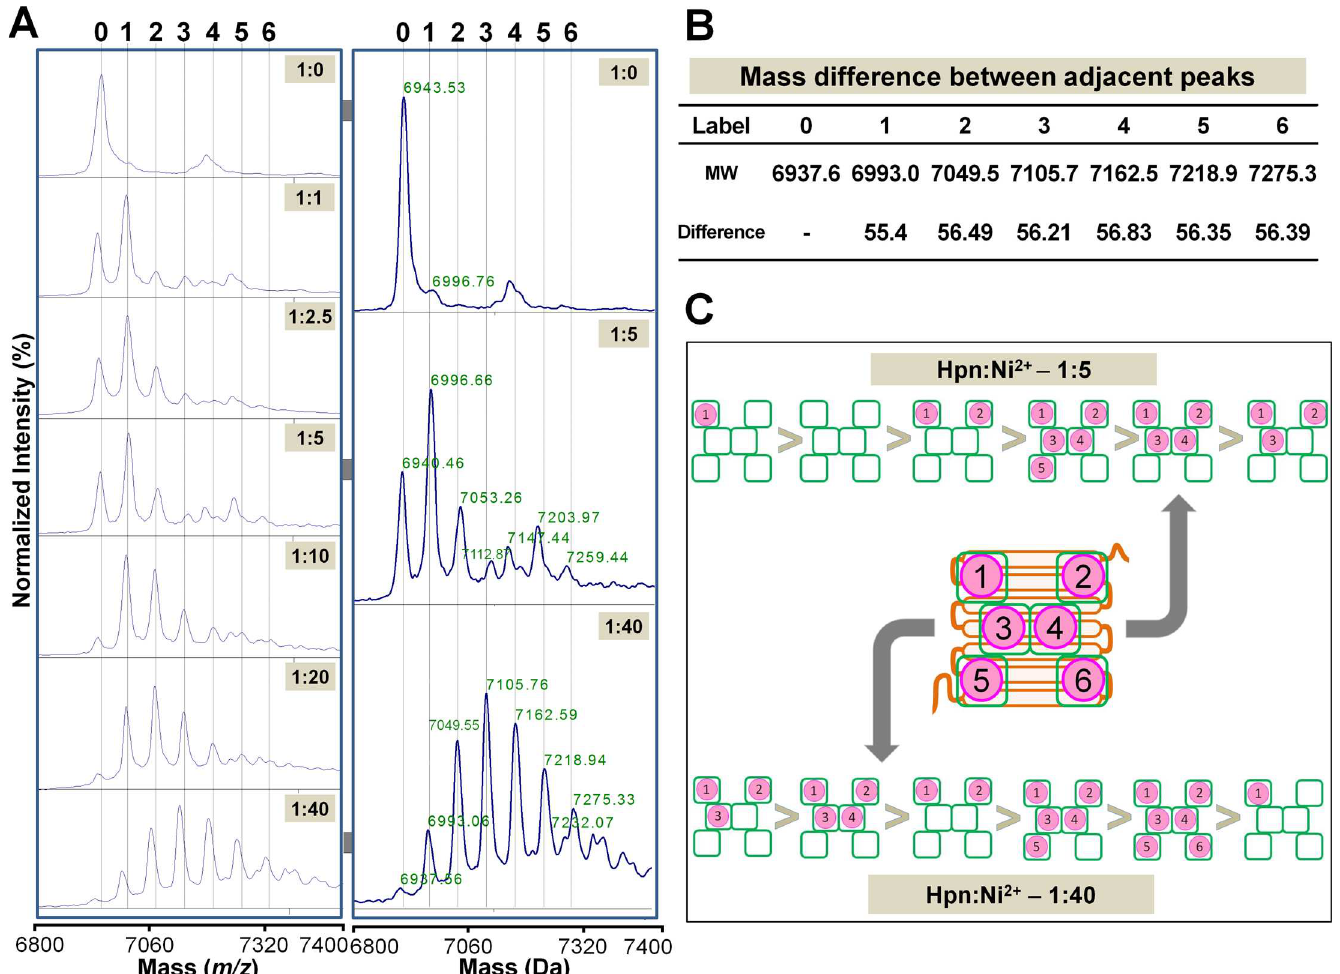
Fig 5. MALDI-TOF-MS analysis of Ni 2+ binding to Hpn. A. Spectra obtainedwith increasingconcentrations of Ni 2+ (1:0, 1:1, 1:2.5, 1:5, 1:10, 1:20 and 1:40, mol equivalent from top to bottom, respectively)added to apo-Hpn(25 μ M) shown in the right panel,and enlargedview of three representative spectra (1:0, 1:10 and 1:40) shown with molecularmass of each peak in the left side. Numbers above dotted line correspondto the number of Ni 2+ bound to Hpn protein. B. Mass difference calculatedbetweenadjacent peaks was found to be approximately equal to the molecularmass of the Ni 2+ ion (58.69) with the loss of two H + atoms (molecularweight [MW] of H + = 1.00794) uponmetal binding.C. Model of Ni 2+ ion bindingto Hpn. Order of occurrence has drawn on the basis of peak intensity obtainedin MALDI-TOF-MS data.